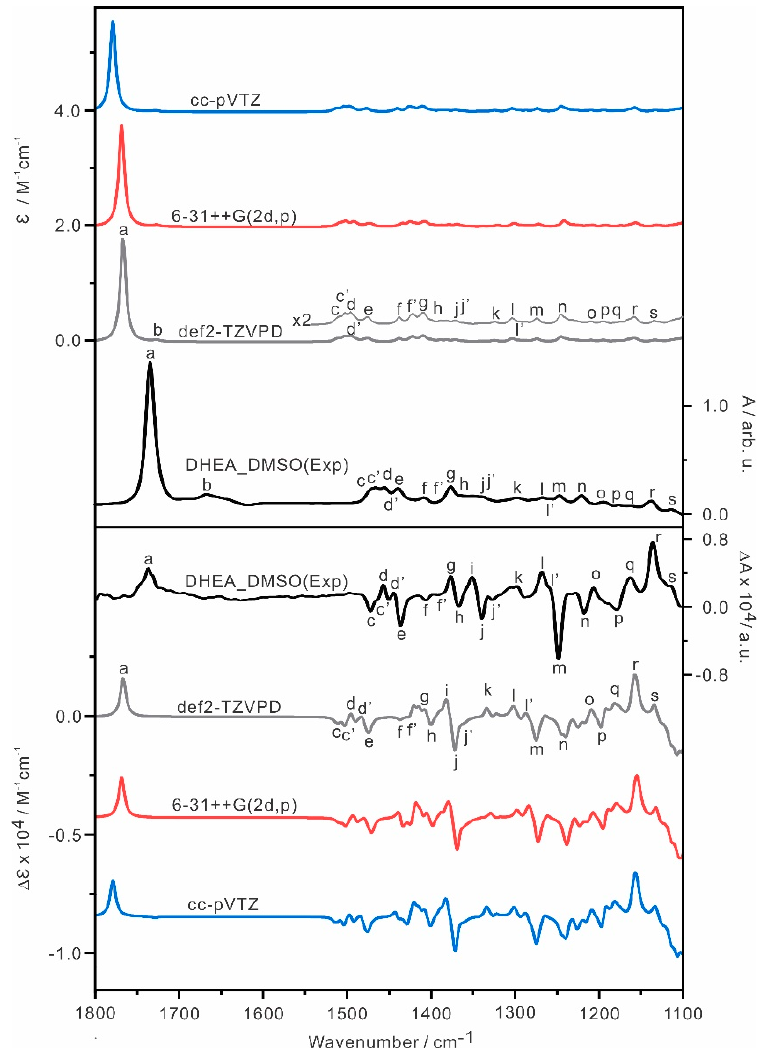
Figure 3. Comparisons of the experimental IR and VCD spectra of DHEA in DMSO − d 6 at room temperature with the Boltzmann averaged IR and VCD spectra of the DHEA conformers with the B3LYP − D3BJ functional and three different basis sets with PCM of DMSO. The experimental units are given on the right side. The main IR and VCD band features are labelled as ‘a’ to ‘s’ to aid the